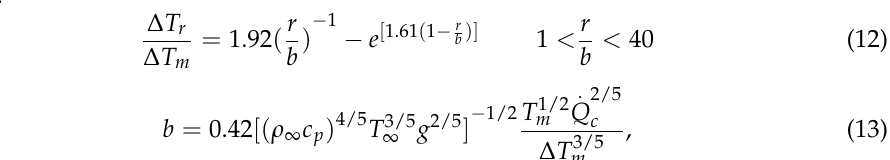
Figure 9. Plotting of temperature attenuation based on Equation (6).